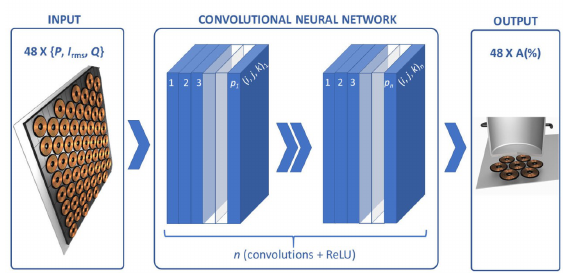
Figure 9. Demonstration of convolutional neural network presented in [32] where the input layer includes power (p), current ( I rms ), and quality factor